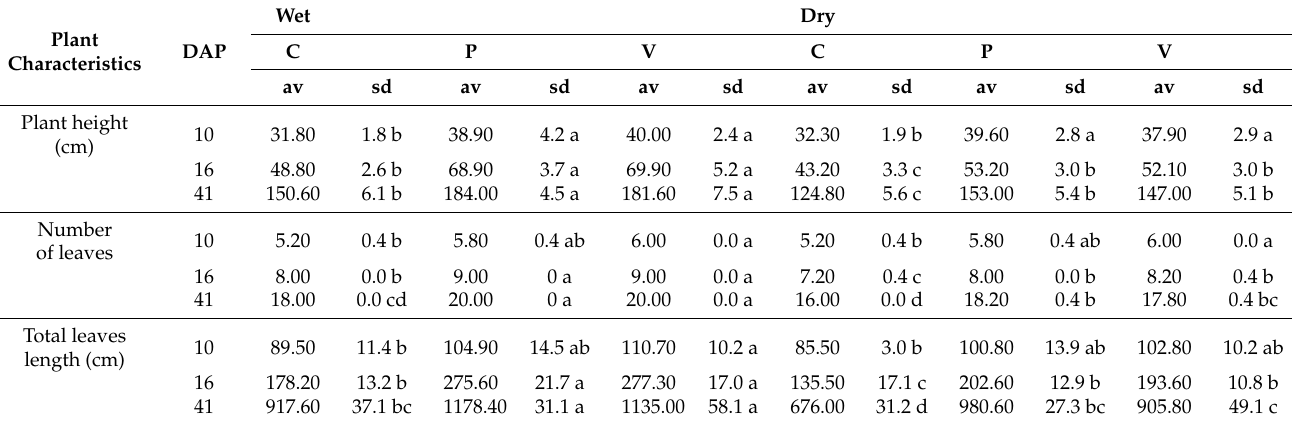
Table 4. Plant characteristics (height in cm, number of leaves, total leaves length in cm) at three periods of the monitoring (10, 16 and 41 DAP) in wet and dry treatments (i.e., columns in which matric potential maintained close to − 150 and − 500 hPa respectively) for the unamended control, compost and vermicompost added columns.